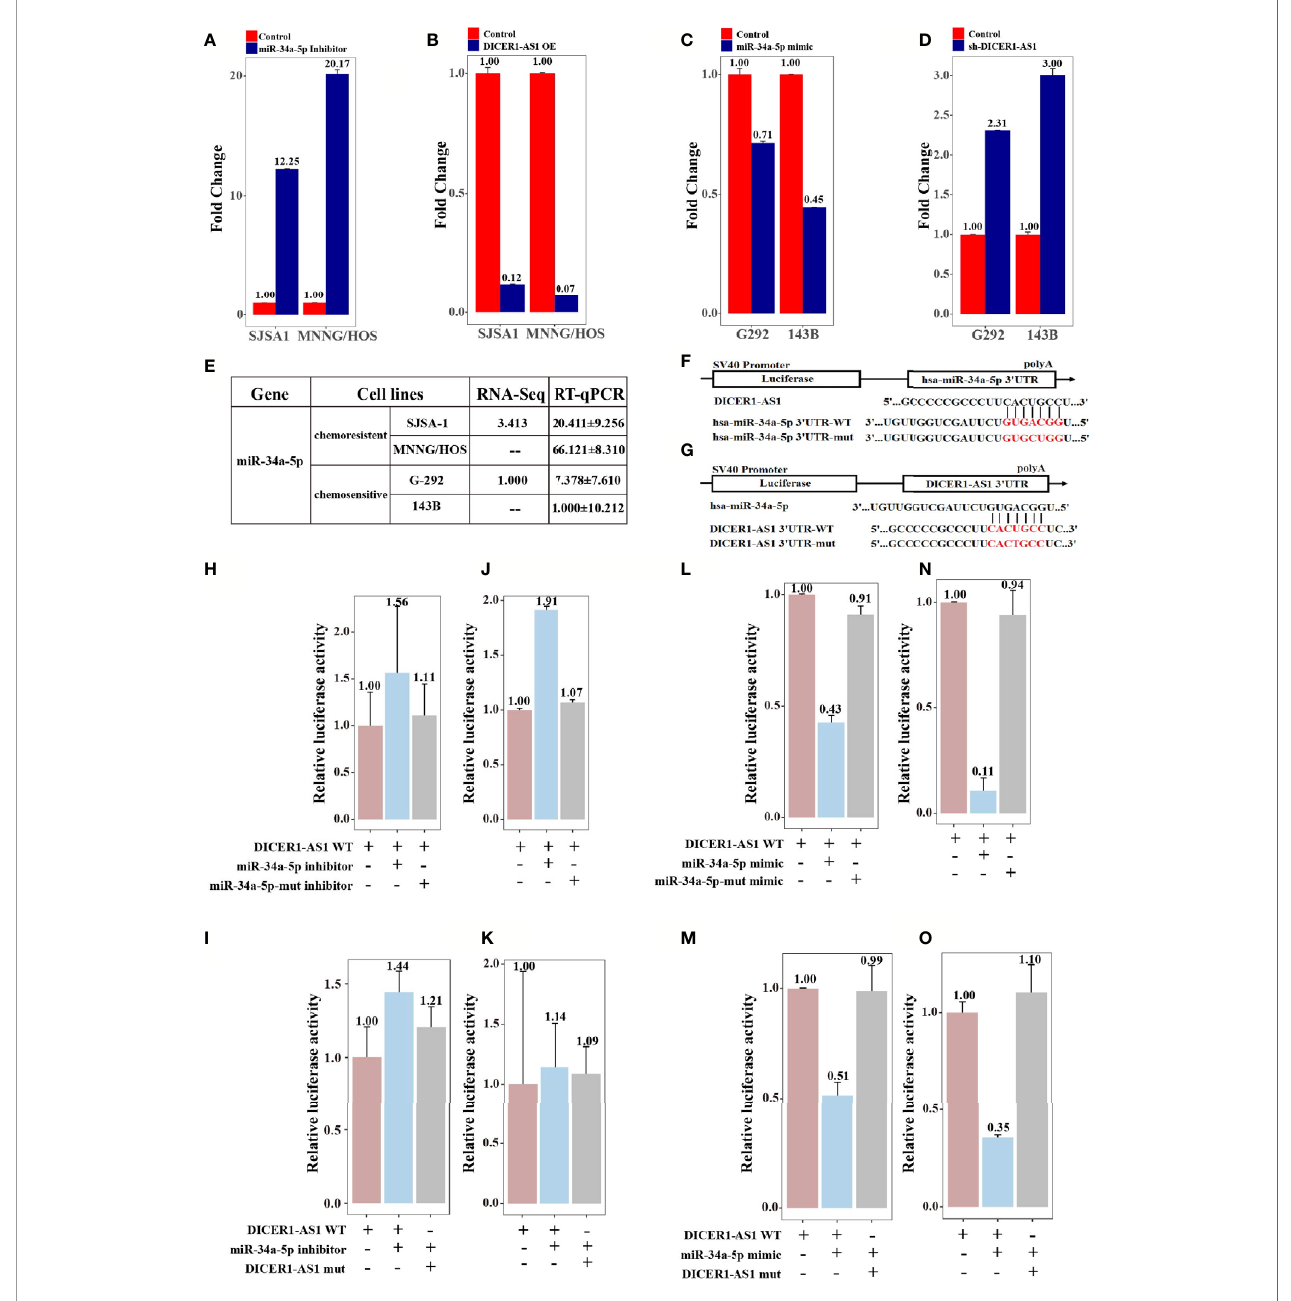
FIGURE 5 | DICER1-AS1 interacts with miR-34a-5p through direct binding in vitro experiments. (A) The relative DICER1-AS1 expression level in the miR-34a-5p inhibitor-transfected SJSA-1 and MNNG/HOS cells versus the negative control (NC), as determined by qRT-PCR analyses. (B) The relative miR-34a-5p expression level in SJSA-1 and MNNG/HOS cells infected with DICER1-AS1-OE versus the negative control (NC). (C) The relative DICER1-AS1 expression level in the miR-34a-5p mimic-transfected G-292 and 143B cells versus the negative control (NC). (D) The relative miR-34a-5p expression level in G-292 and 143B cells transfected with shDICER1-AS1 versus the negative control (NC). (E) The relative miR-34a-5p level (fold) in G-292 and 143B cells versus SJSA-1 and MNNG/HOS cells measured by both miR-omic and qRT-PCR analyses were shown, “—” indicates no detection in the omic analysis. (F) Luciferase reporter constructs: WT and mut miR-34a-5p in the DICER1-AS1-binding sites were inserted into psiCHECK-2 vector. The red base region is the binding site. (G) Luciferase reporter constructs: WT and mut DICER1- AS1 in the miR-34a-5p-binding sites were inserted into psiCHECK-2 vector. The red base region is the binding site. (H, J) The relative luciferase activity of psiCHECK- 2 containing WT-DICER1-AS1 co-transfected with NC, miR-34a-5p-inhibitor or miR-34a-5p-mut inhibitor in SJSA-1 and MNNG/HOS cells. (I, K) The relative luciferase activity of psiCHECK-2 containing WT or mutated DICER1-AS1 co-transfected with miR-34a-5p-inhibitor in SJSA-1 and MNNG/HOS cells. (L, N) The relative luciferase activity of psiCHECK-2 containing WT DICER1-AS1 co-transfected with NC, miR-34a-5p mimic or miR-34a-5p mut mimic in G-292 and 143B cells. (M, O) The relative luciferase activity of psiCHECK-2 containing WT or DICER1-AS1-mut co-transfected with miR-34a-5p-mimic in G-292 and 143B